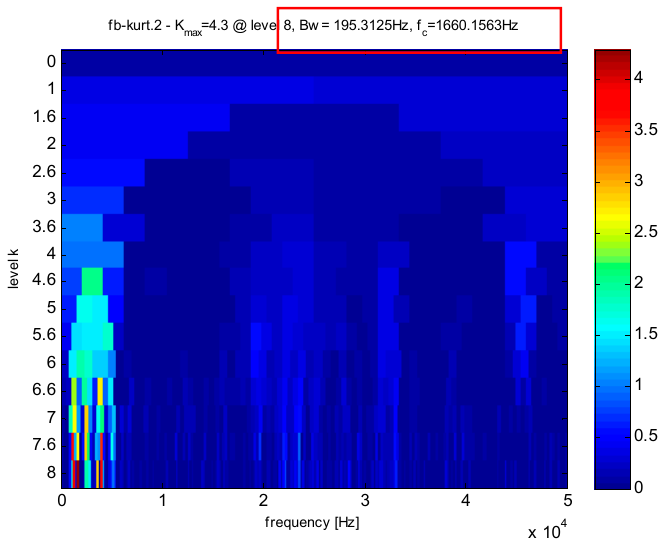
Figure 28. Kurtogram of the signals as shown in Figure 25. Sensors 2016 , 16 , 1524